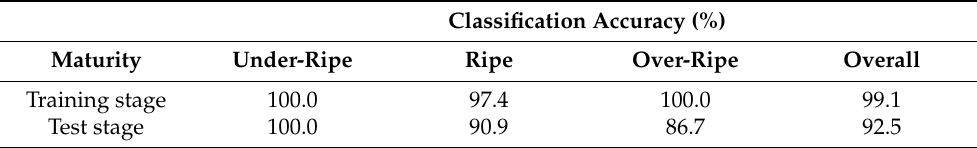
Table 11. The classification accuracy of the training stage and test stage for